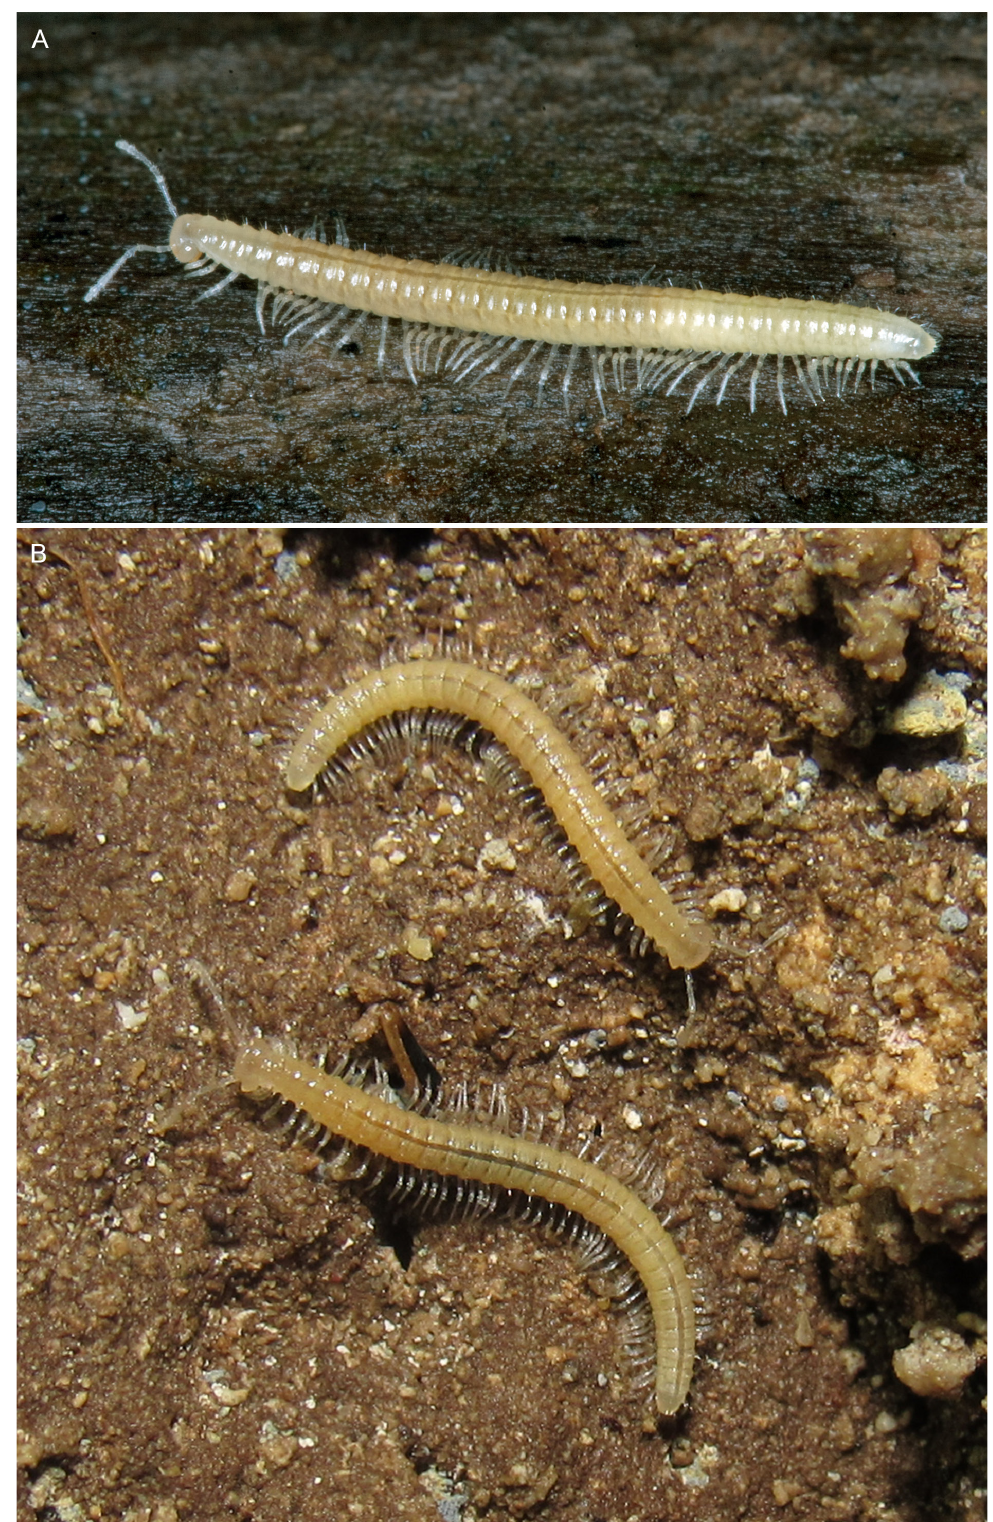
Fig. 10. Habitus. A . Biokoviella mauriesi Mršić, 1992, ♀, topotype (photo by H. Bilandžija). B . Biokoviella mosorensis Antić & Dražina sp. nov., ♂ and ♀ from the type serie (photo by D.A.). Without